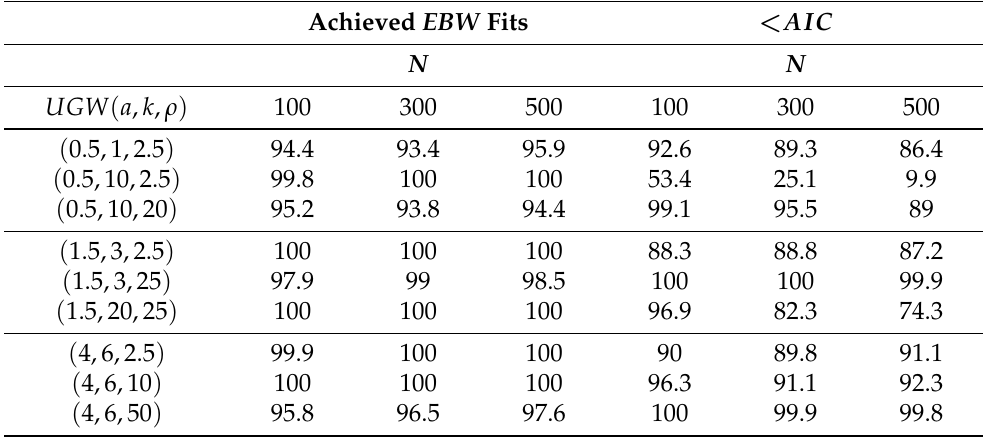
Table 1. Percentage of: (1) EBW fits achieved for UGW generated data; (2) EBW fits with less AIC value than the corresponding UGW